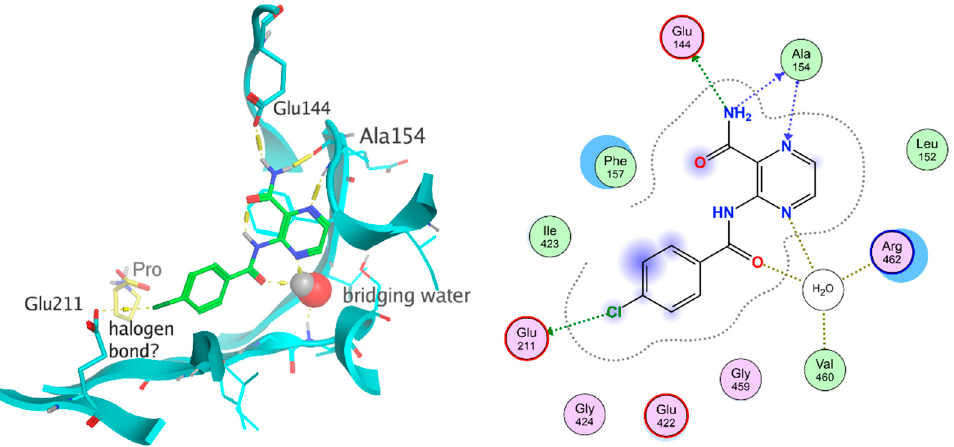
Figure 3. Representative binding mode of compound 15 as optimized by molecular dynamics. Left: in 3D depiction, right: ligand–protein interaction diagram (2D). Table 6. Abundance of ligand ‐ receptor hydrogen bonds in the production stage of MD simulation for compounds 15 and 34 .